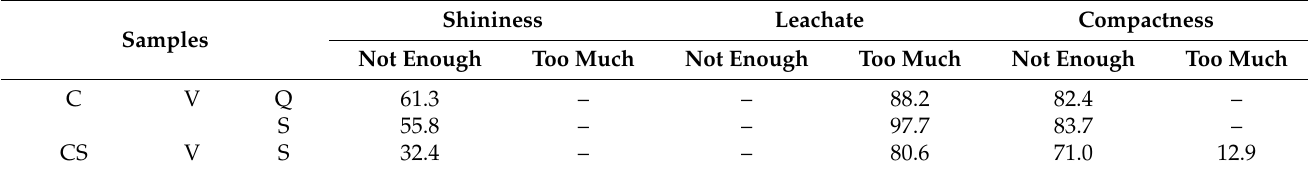
Table 4. Consumer penalty analysis of the just-about-right (JAR) diagnostic